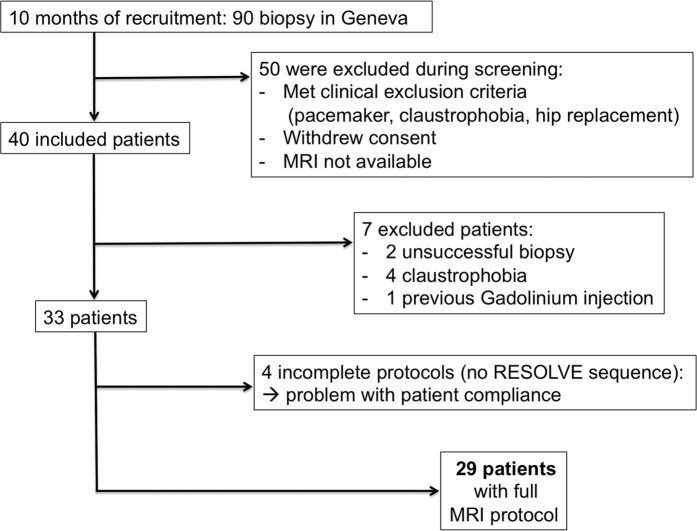
Flowchart illustrating patient recruitment.